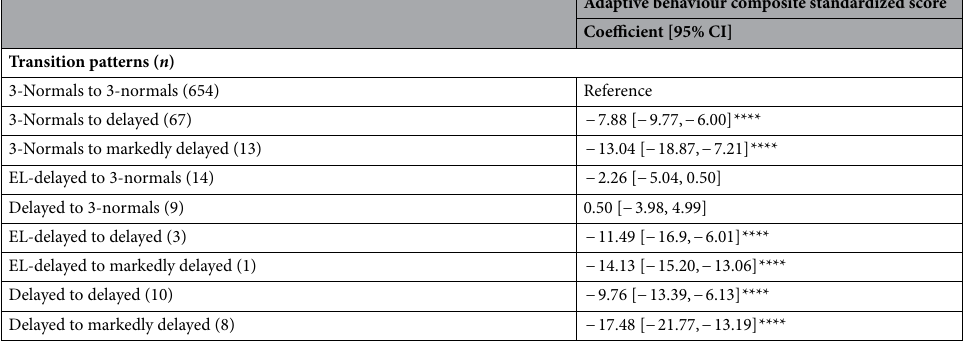
Table 4. Association between neurodevelopmental transition patterns and adaptive behaviour at 40 months in linear regression analyses with covariates ( n = 779). CI confidence intervals, EL-delayed expressive language delayed. ****P < 0.001. a Infant sex (male), premature birth (< 37 weeks), low placenta-to-birth-weight ratio (< 10th percentile), household income, maternal body mass index at pre-pregnancy (> 25 kg/m 2 ), small-for- gestational-age (< 10th percentile), infant’s standardised body mass index at 18 months of age (> 1 SD), and maternal educational